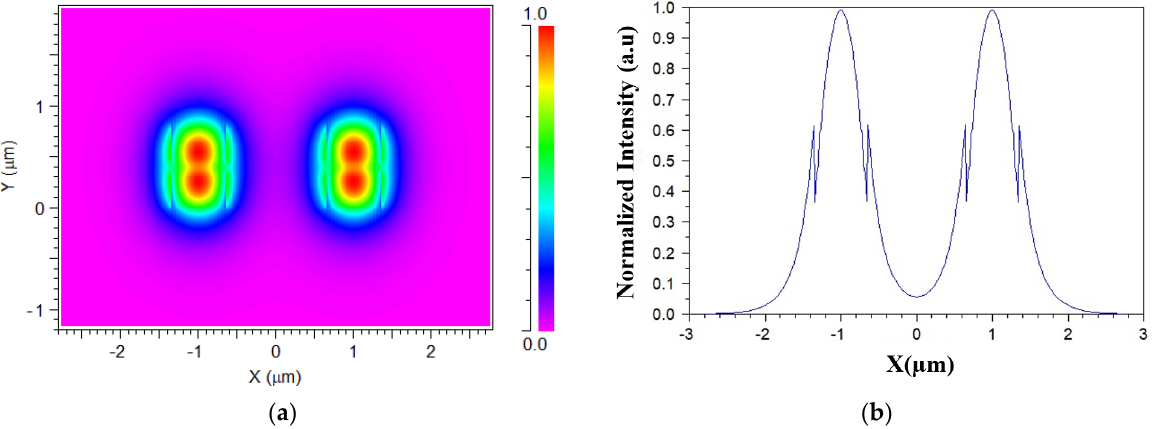
Figure 2. Solution of the TE fundamental mode for 2 × 1 power combiner: ( a ) E y polarization mode profile; ( b ) horizontal view at y = 220 nm.